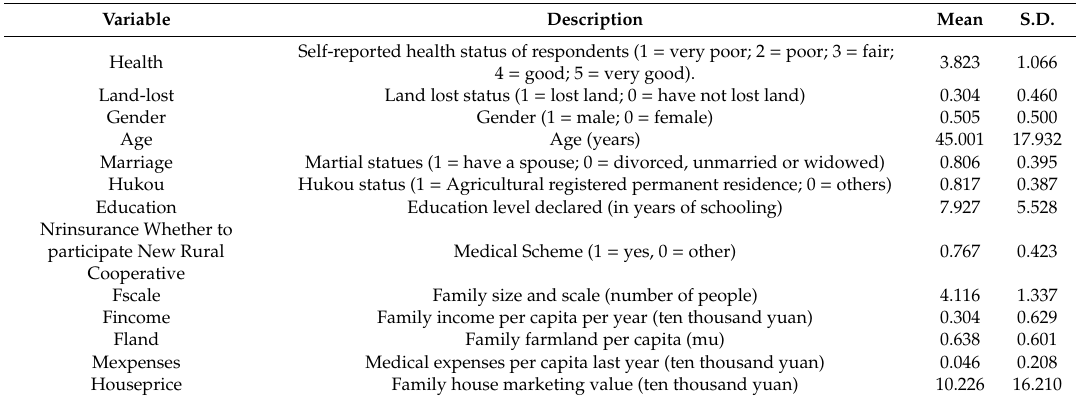
Table 1. Variable descriptions and descriptive